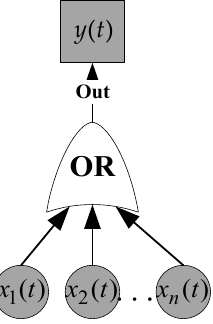
Figure 1. The RDFTA OR logic gate. Table 2. The quantitative operation rules of the OR gate.